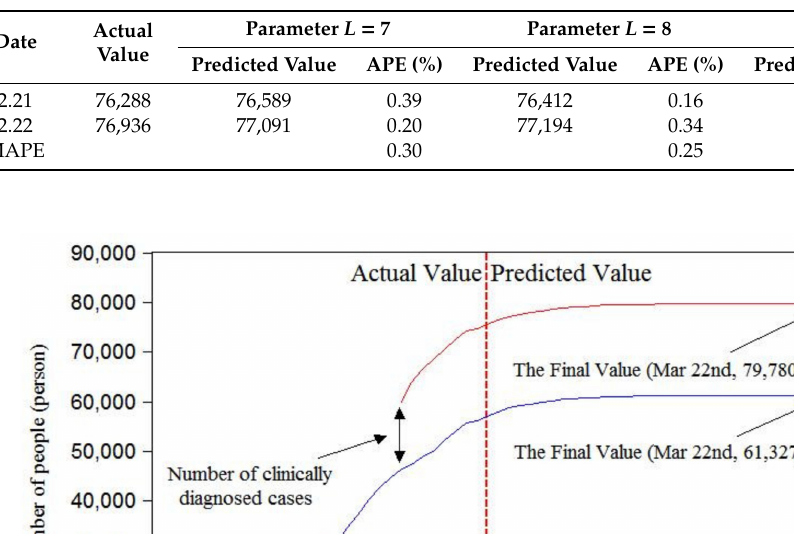
Table 6. Out-of-sample prediction accuracy.